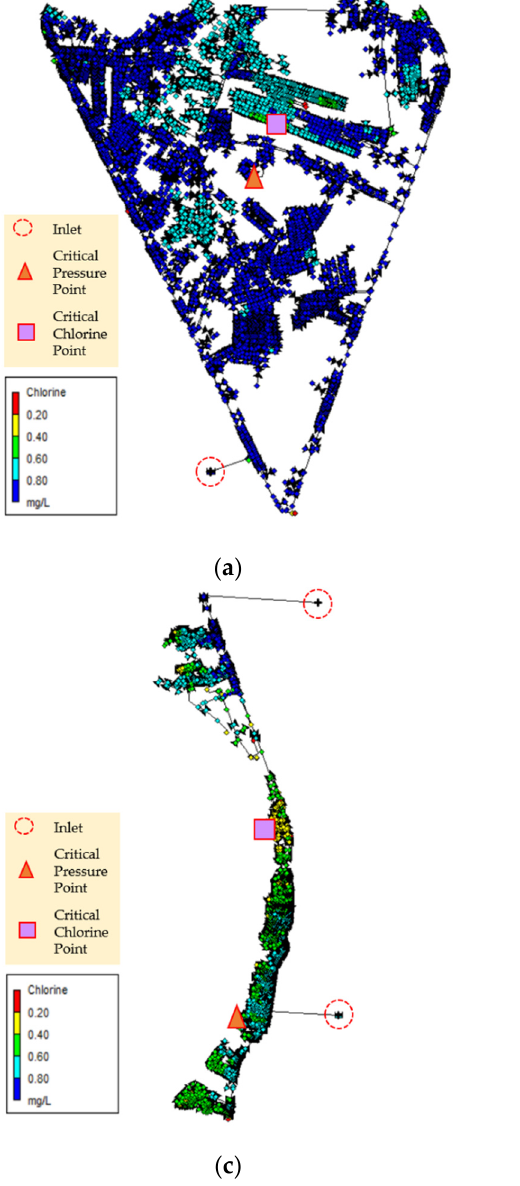
Figure 5. Examples of residual chlorine distributions in DMA networks, where ( a , b ) are networks with 1 inlet, and ( c , d ) are networks with 2 inlets. Red dashed circles show the inlets connected to networks by imaginary pipes with no friction loss; orange triangles represent critical pressure points (CPPs) and pink rectangles are critical chlorine points.